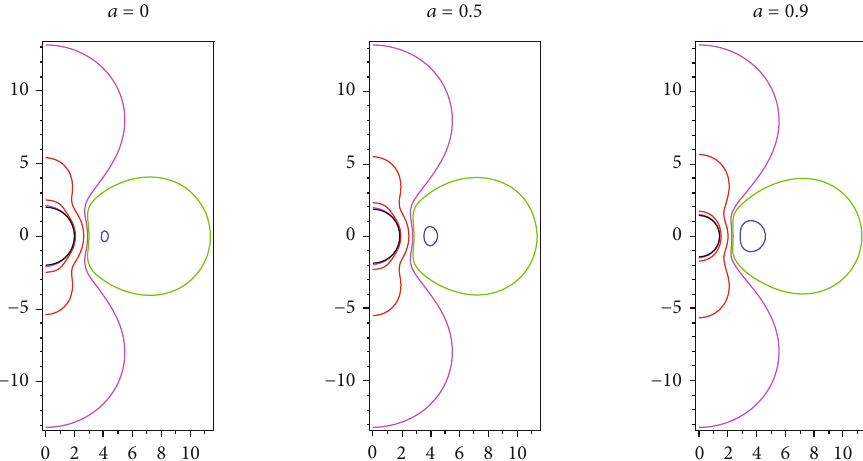
Figure 1: Contours of pro fi les of revolution around the vertical axis (rotation axis) depicting constant current density lines (36) corresponding to Example 1 for three di ff erent values of the Kerr parameter a . The red curve corresponds to J = 0 : 0001 , blue to J = − 0 : 0001 , magenta to J = 0 : 00003 , and green to J = − 0 : 00003 . The black circle is the black hole ’ s horizon. a = 0 a = 0.5